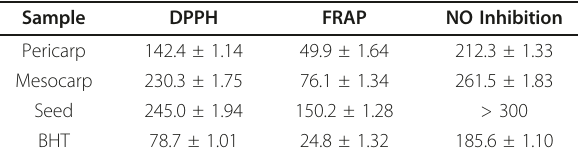
Table 2 The IC 50 values of extracts and standards on free radical, reducing power and nitric oxide scavenging